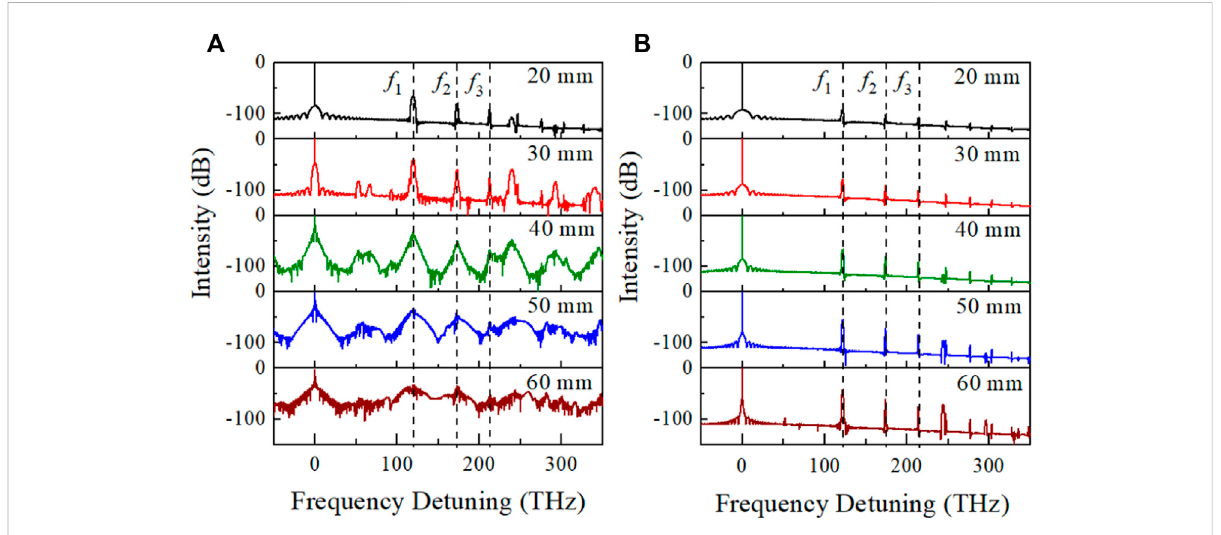
FIGURE 4 (Color online) Spectrum pro fi le at different distances excited by the partial Gaussian beam with the peak power (A) P p (cid:2) 300kW and (B) (cid:2) 142kW when spotsize w (cid:2) 30 μ m. The frequency detuning of the fi rst, second, and third sideband centers f P P i black dotted lines, respectively. Here, κ ″ (cid:2) 1 . 75s − 26 /m, and the other parameters are the same as in Figure 2.